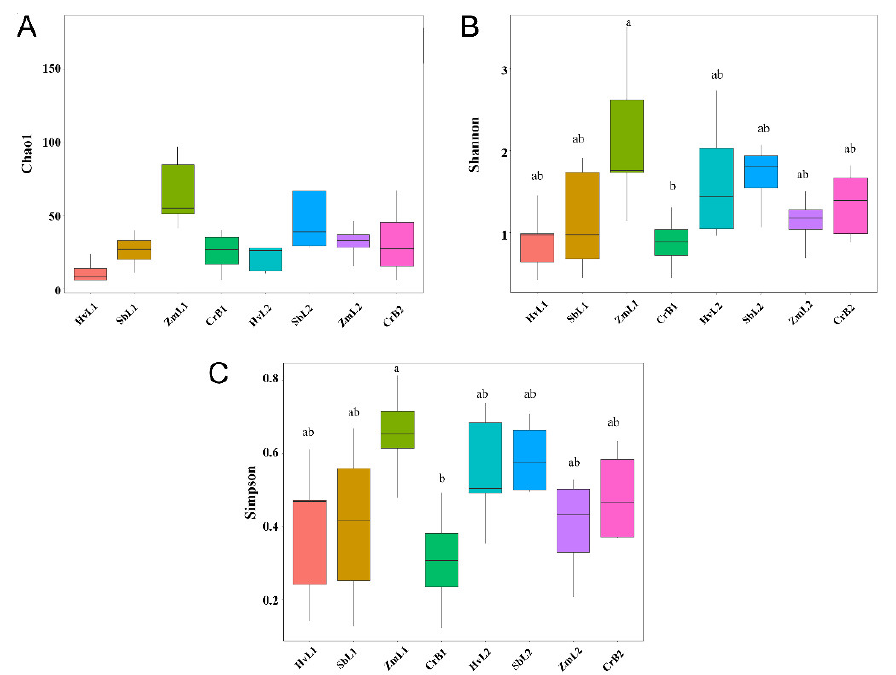
Figure 3. Box plots of ( A ) Chao1, ( B ) Shannon, and ( C ) Simpson α diversity indices of gut bacterial communities in S. frugiperda larvae fed on leaves of different host plants. The a and b indicate the significant differences in relative abundance in the same column in the mean values. Different letters above boxes indicate significant differences among treatments (one-way ANOVA, Tukey’s post hoc test) in the mean values.